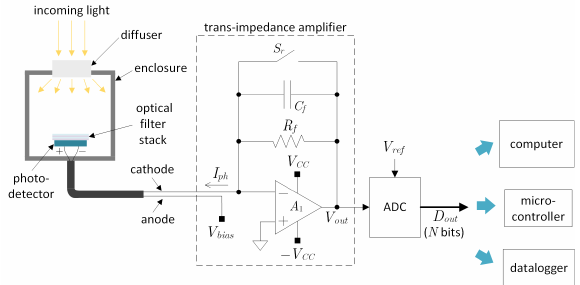
Fig. 5. Common architecture of a PAR